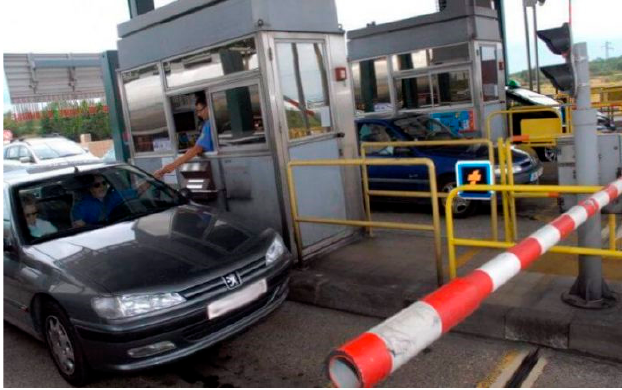
Figure 5. Example of entry and exit gates of a DWCS road.